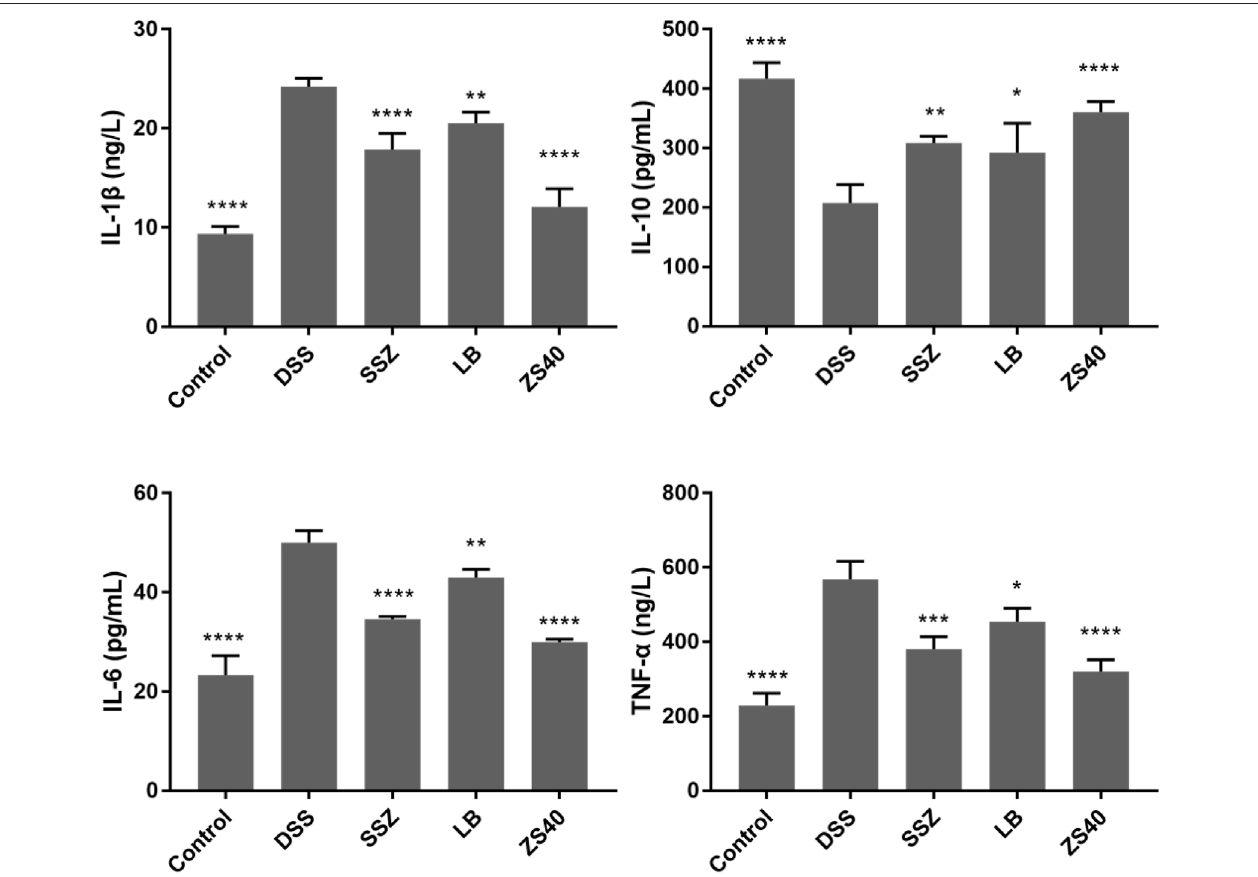
FIGURE 5 | Cytokine levels (IL-1 β , IL-6, IL-10, and TNF- α ) in serum of mice. Control group (cid:2) gavage with saline, DSS group (cid:2) 3% dextran sulfate sodium, SSZ group (cid:2) 500 mg/kg body weight (b.w.) salicylazosulfapyridine treatment dose, LB group (cid:2) 1.0 × 10 9 CFU/kg body weight (b.w.) L. bulgaricus treatment dose, ZS40 group (cid:2) 1.0 × 10 9 CFU/kg body weight (b.w.) L. fermentum ZS40 treatment dose. Dataareexpressed asmean ± SD; * p < 0.05, ** p < 0.01, *** p < 0.001, **** p < 0.0001 compared with the DSS